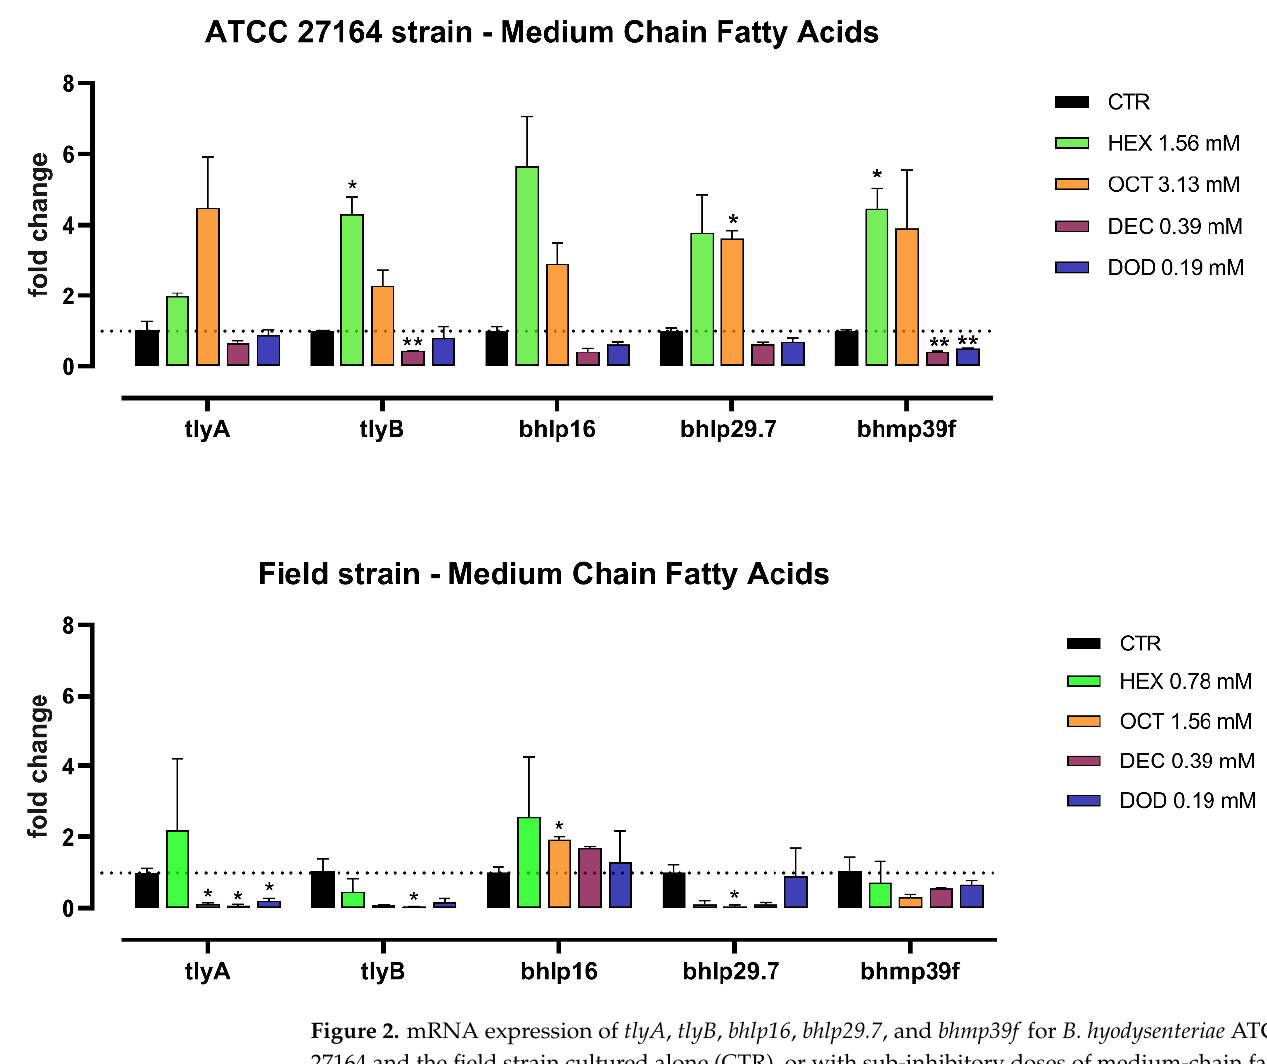
Figure 2. mRNA expression of tlyA , tlyB , bhlp16 , bhlp29.7 , and bhmp39f for B. hyodysenteriae ATCC 27164 and the field strain cultured alone (CTR), or with sub-inhibitory doses of medium-chain fatty acids. Data are presented as mean (n = 3) ± SEM. For each gene, significant differences between each substance and its control are marked by asterisks (* for p < 0.05 and ** for p < 0.01). HEX = hexanoic acid, OCT = octanoic acid, DEC = decanoic acid, DOD = dodecanoic acid.